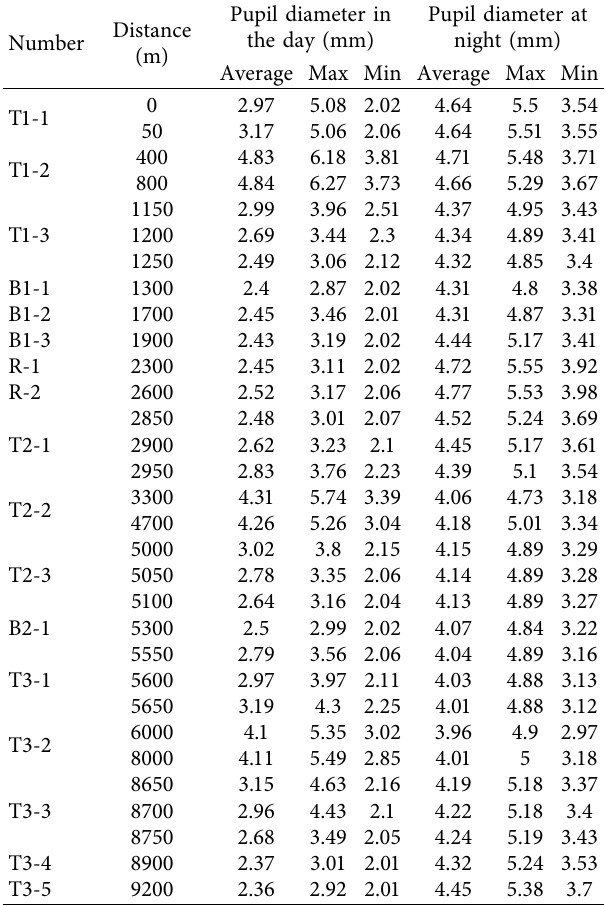
Table 3: Distance-pupil diameter information of the characteristic